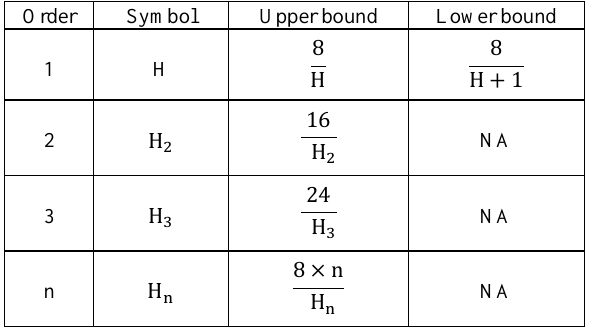
Table 3 Higher-order Shannon entropies and bounds for an 8-bits image